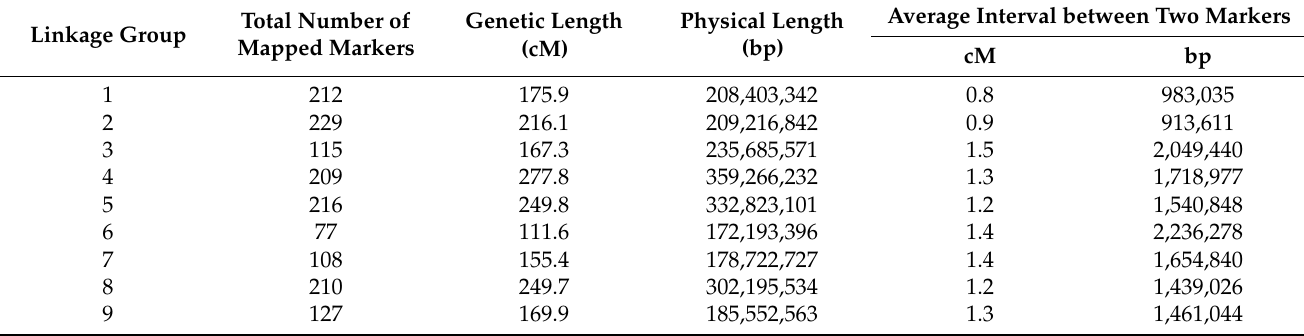
Table 3. Summary statistics of the lettuce intraspecific genetic linkage map constructed using the F5 RIL population derived from Lactuca sativa cv. Chimasanchu × L. sativa cv. Banchu Red Fire. Linkage